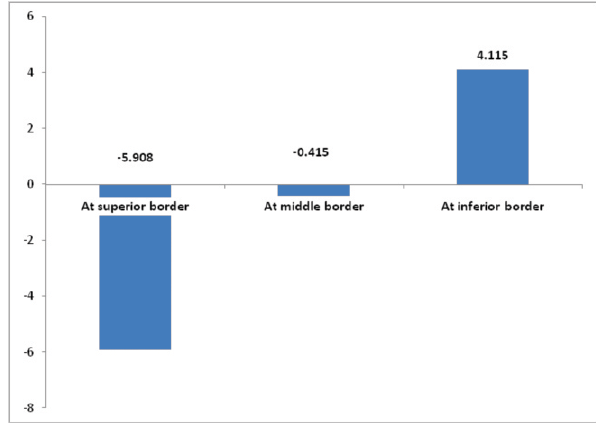
Chart 1: Parallelism (A-P measurement) of the maxillary occlusal plane with ala and various levels of tragus border.